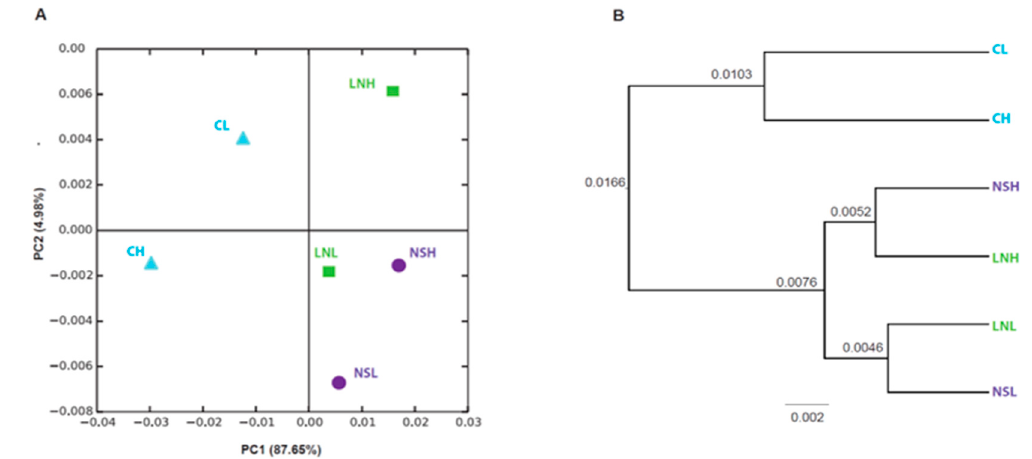
Figure 1. Beta diversity of mopane soil samples based on unweighted UniFrac distances. ( A ) Two-dimensional unweighted PCoA plot showing the separation of each sample type. ( B ) UPGMA tree showing the phylogenetic relationships between samples. C: Calcrete; LN: Lebombo North; NS: Nwambia Sandveld; H: high fire frequency; L: low fire frequency.